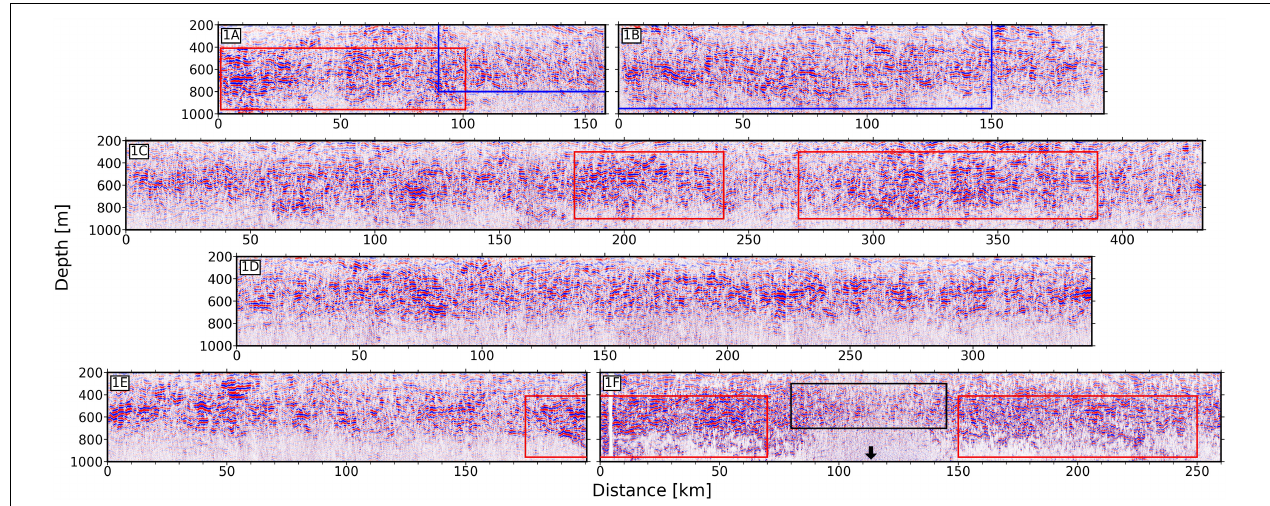
FIGURE 4 | Seismic sections from west (line 1A) to east (line 1F). Red boxes = locations of continuous, high amplitude reflections; blue boxes = an example location of shorter, discontinuous reflections; black box = water mass above the MAR. Black arrow = location of crest of the